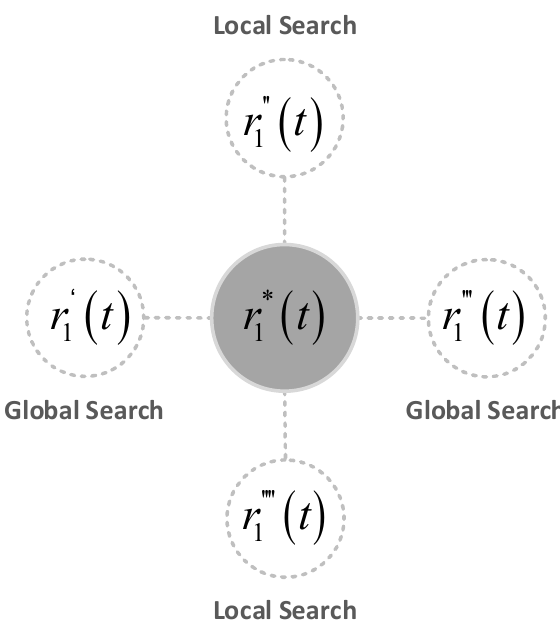
Figure 2. Multilevel regulatory factor. The multilevel regulatory factor is defined in Equation (7). The number of iteration rounds was split into four phases with T 1 = [ 0, 1